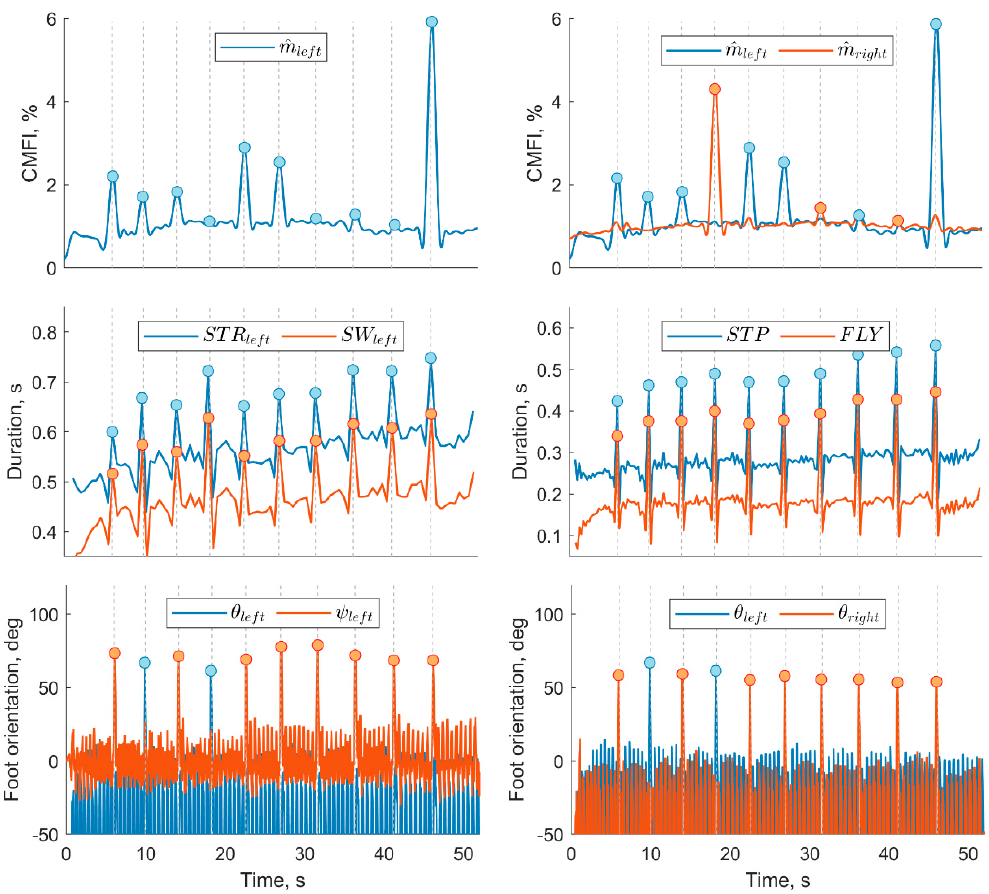
Figure 7. Detection results obtained by MAG ( top ), TEMP ( middle ), and ORIENT ( bottom ) methods for one trial. The magnetometer graphs show the calibrated magnetic field intensity (CMFI) in percent of the Earth’s magnetic field. The column on the left shows the detection results in unipedal configuration and on the right for bipedal detection. The vertical grey dashed lines represent the reference HC events. Table 2. Hurdle clearance and leading leg detection results for both unipedal and bipedal configurations. In total, 15 trials with each N hurdles = 10 hurdle clearances were available for the performance